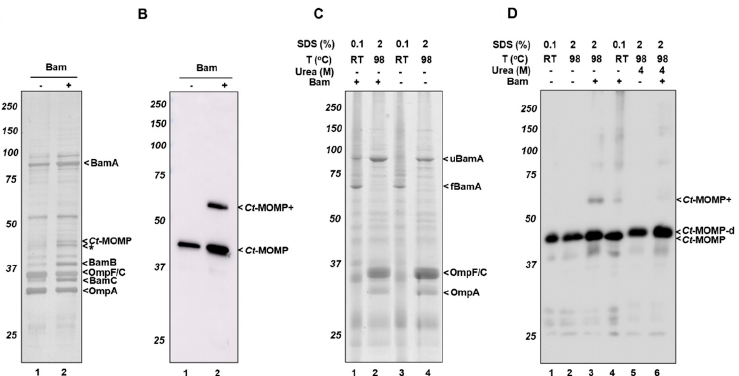
Figure 5. Localization and heat-modifiability of Ct -MOMP in the E. coli OM. Sucrose density gradient fractions 10–12 derived from cells expressing Ct -MOMP either in the absence ( − ) or presence (+) of the Bam complex (see Figure 4) were pooled and subjected to ultracentrifugation to collect the OMs. After washing, the membranes were analyzed by SDS-PAGE and silver staining ( A ) or immunoblotting using Ct -MOMP antiserum ( B ). The same samples were used for analyzing the heat-modifiability of Ct -MOMP. Membranes were solubilized in the presence of 0.1% ( w / v ) SDS to obtain semi-native samples or 2% ( w / v ) with or without 4 M urea to obtain denatured samples. Samples were kept at room temperature (RT) or heated (98 ◦ C) prior to analysis by semi-native SDS-PAGE followed by Coomassie staining ( C ) and immunoblotting ( D ). A silver-stained band at ~41 kDa representing Ct - MOMP that could be identified through immunoblotting was indicated ( Ct -MOMP). A similar-sized silver-stained product that was not detected by Ct -MOMP antiserum (*) and the ~60–65 kDa band potentially representing a higher-order form of Ct -MOMP was also annotated ( Ct -MOMP+). In panel C, bands representing folded BamA (fBamA) and denatured unfolded BamA (uBamA) were